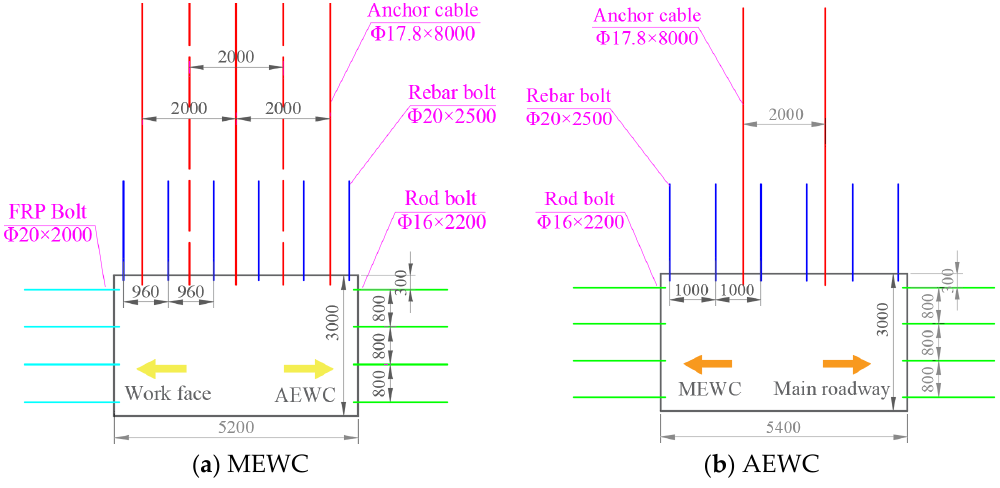
Figure 3. Support profile of the EWCs (mm).